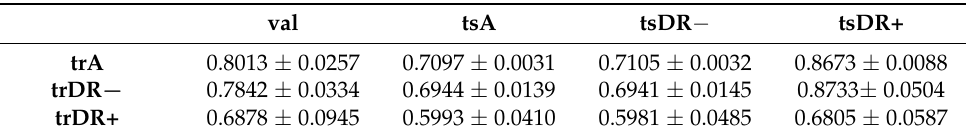
Table 5. AUC for the model trained and tested on different subsets (rows: training set, columns: evaluation